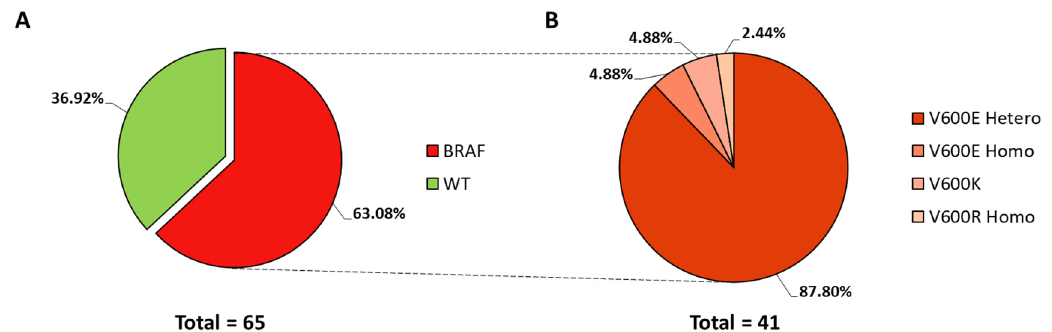
Figure 1. Pie charts representing the percentage of wild-type (WT) and BRAF mutated samples. ( A ) Percentage of BRAF mutated samples including all variants. ( B ) Percentage of BRAF mutation variants detected in exon 15 (V600) regarding total BRAF mutated samples. Homo, homozygotic; hetero, heterozygotic.